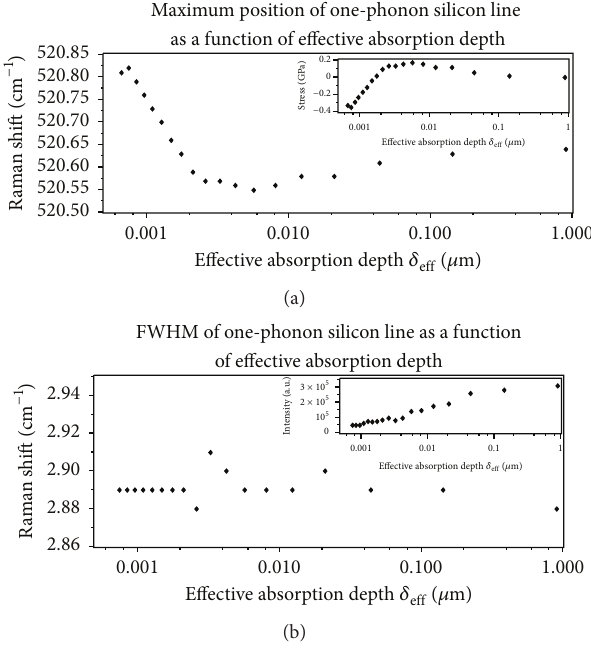
Figure 2: Raman data obtained with excitation in visible spectral range: (a) position of maximum of one-phonon Si line as a function of effective absorption depth and (b) FWHM of one-phonon Si line as a function of effective absorption depth . Insets present following functions of effective absorption depth : panel (a) mechanical stress in silicon calculated from position of one-phonon Si line and panel (b) intensity of the one-phonon Si